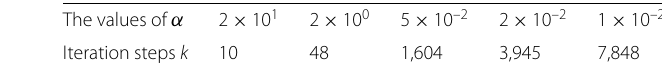
Table 2 The comparison of iteration steps k with different α for Example 2 The values of α